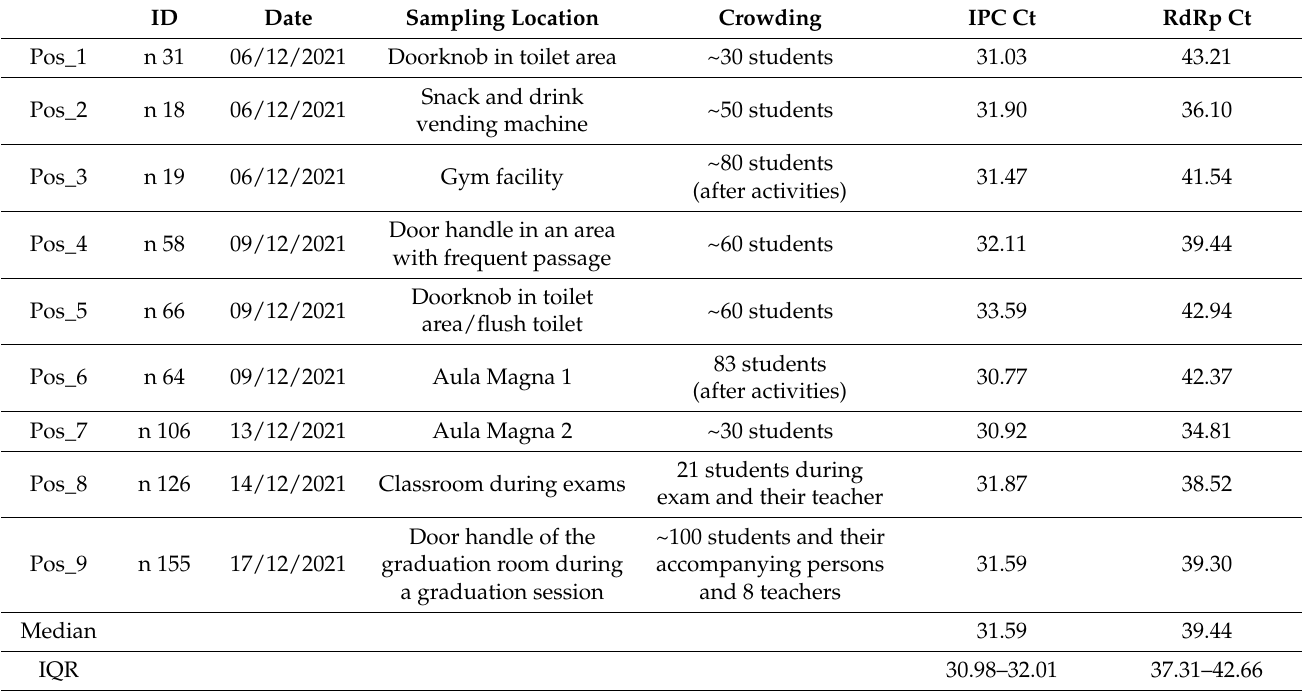
Table 1. Characteristics of positive environmental samples for SARS-CoV-2 RNA.